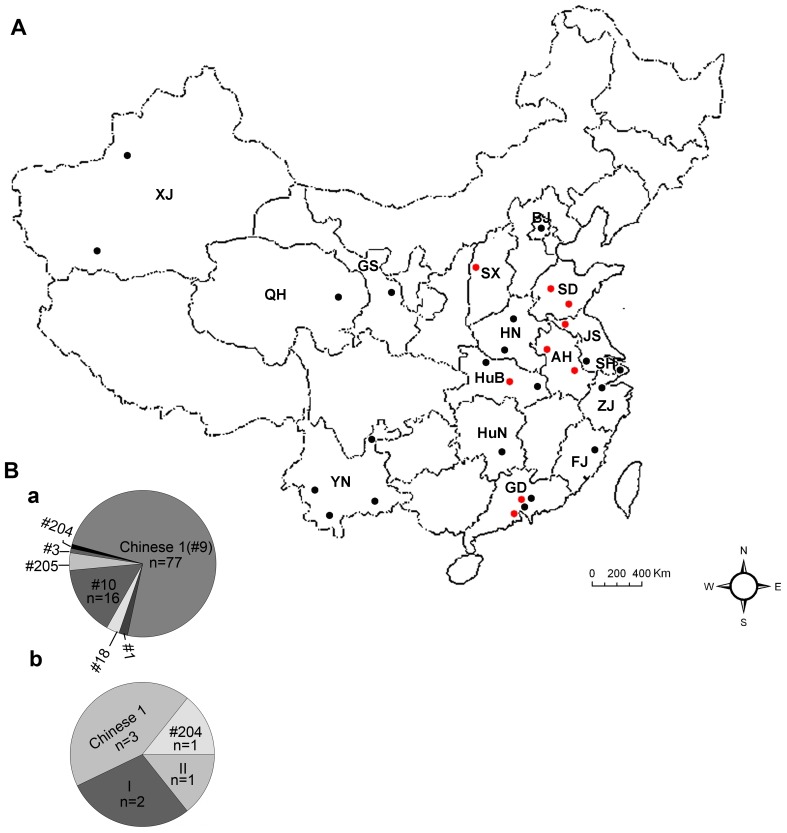
The genotypes and geographic regions of T. gondii Chinese isolates.Panel A: a map of China to show the cumulative data of geographic distribution where the Chinese isolates of T. gondii used for genotyping were collected. The provinces and cities where T. gondii isolates were obtained and indicated by red dots and black dots, respectively. Red dots represent the locations (counties) where the isolates were collected in this work. Black dots indicate the locations (counties) where the isolates were collected in the early studies. SX: Shanxi province; SD: Shandong province; HN: Henan province; AH: Anhui province; JS: Jiangsu province; HuB: Hubei province; HuN: Hunan province; GD: Guangdong province; ZJ: Zhejiang province; FJ: Fujian province; YN: Yunnan province; QH: Qinghai province; GS: Gansu province; XJ: Xinjiang province; BJ: Beijing city; SH: Shanghai city. Panel B: a: the cumulative data of genotypes of T. gondii Chinese isolates. b: the genotypes of T. gondii isolates from human patients in mainland China. This is the first report of the genotype ToxoDB#204 from humans.